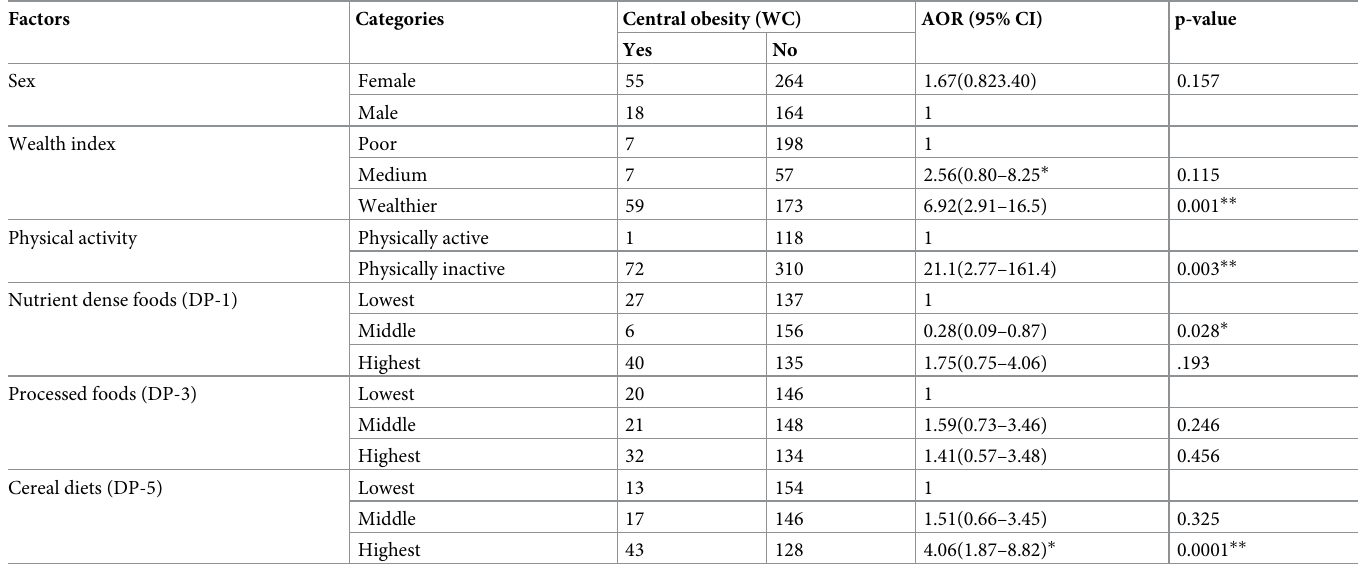
Table 4. Adjusted association between dietary patterns and central obesity among adults from Dire Dawa and Harar, Eastern Ethiopia.